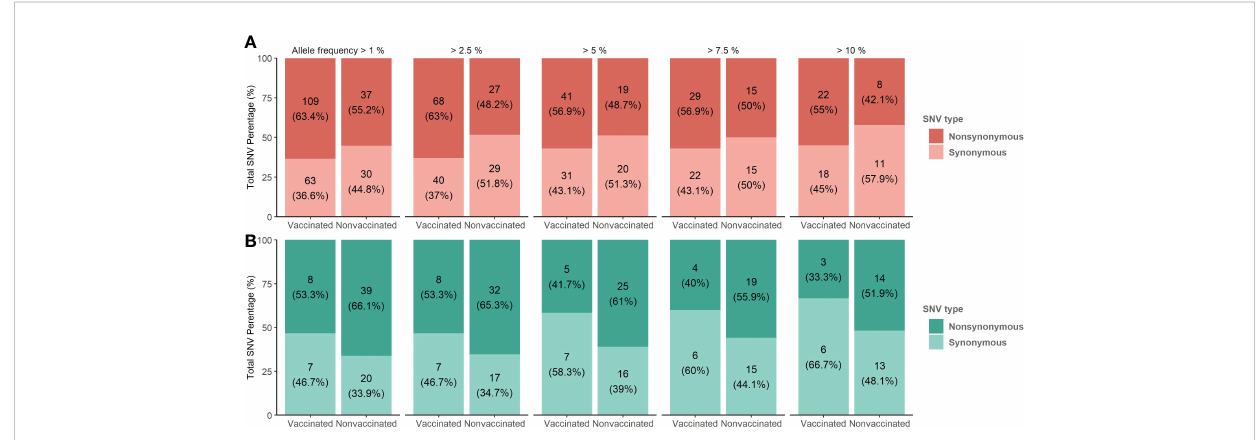
FIGURE 7 De novo synonymous and nonsynonymous SNV proportion bars in samples from vaccinated and nonvaccinated animals at different allele frequencies. (A) SNV proportions found in the H1N1 subtype are represented in red bars (B) SNV proportions found in the H3N2 subtype are represented in green bars. The total number of SNV and its percentages are indicated in each bar. Dark and soft colors represent nonsynonymous and synonymous SNV,